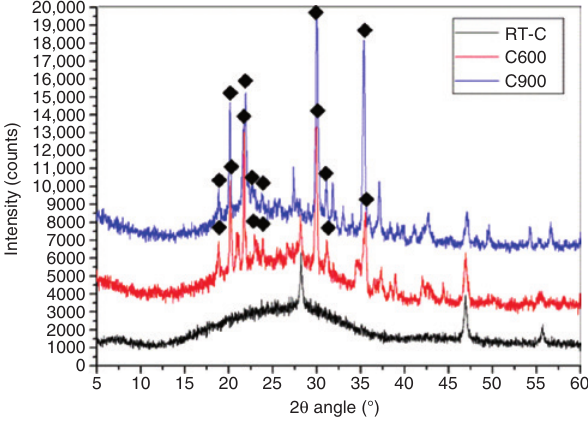
Figure 6: XRD pattern of sample C at room temperature (RT-C), C600 and C900 ( ♦ : sodium zinc phosphate (NaZnPZnO